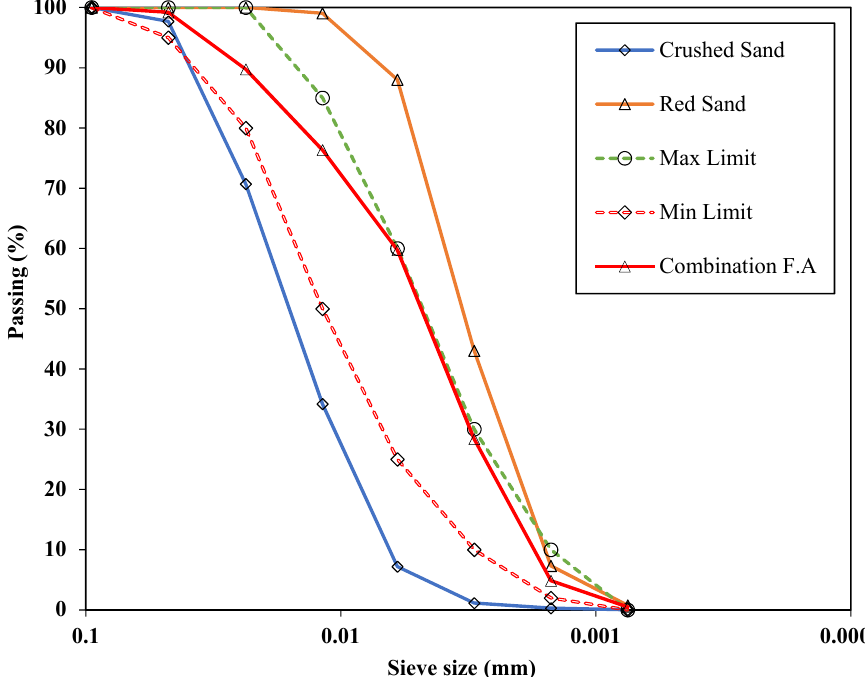
Figure 3. Particle size distribution of fine aggregate used in this study